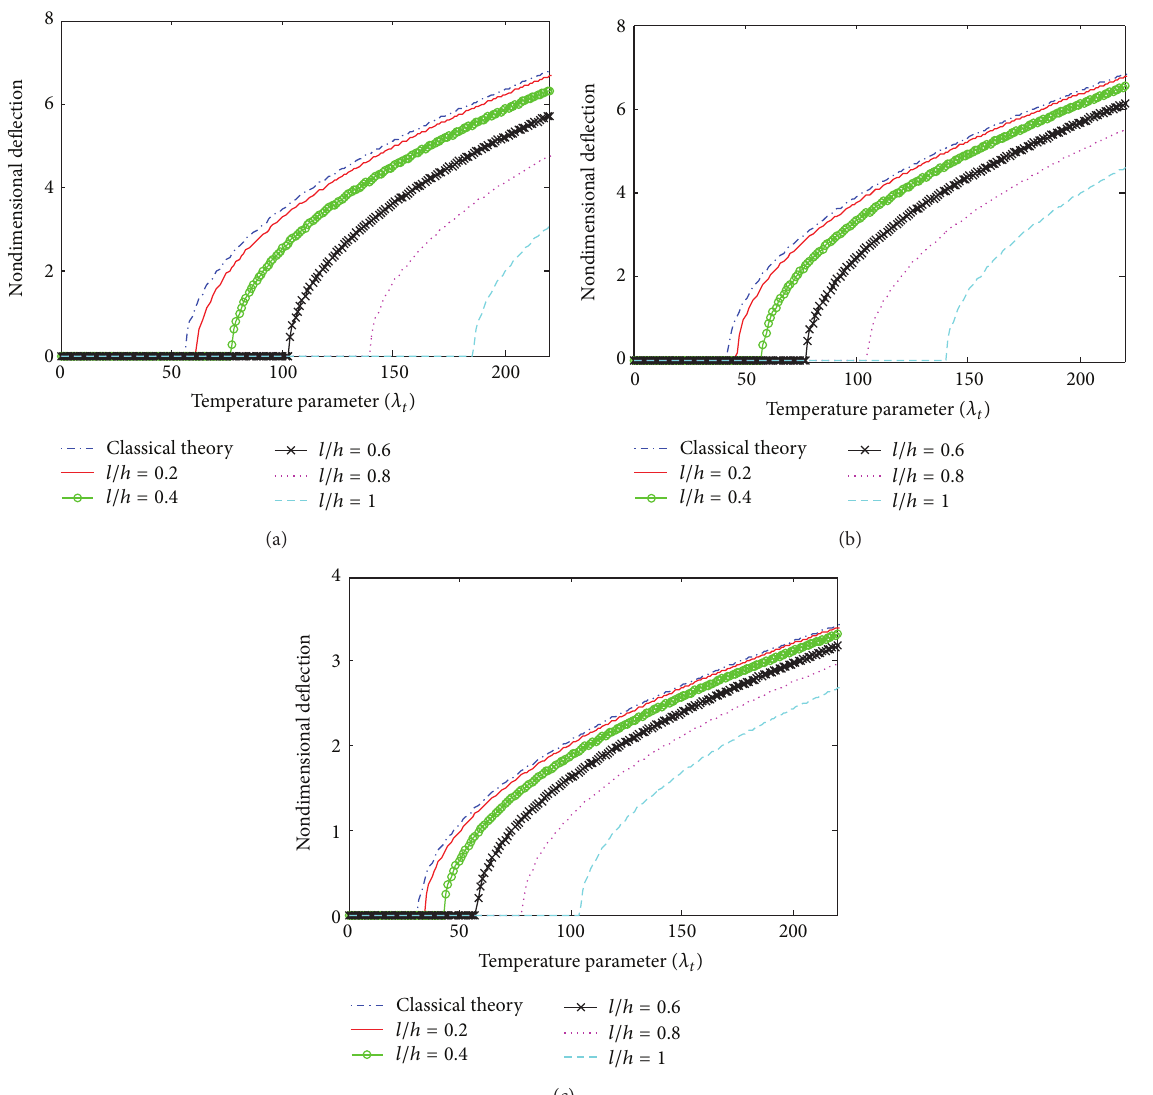
Figure 7: Variation of the nondimensional deflection ( ̂𝑥 = 0.25 ) of (a) clamped-clamped, (b) clamped-simply supported, (c) simply supported-simply supported FG beam with the temperature parameter for different values of 𝑙/ℎ ( 𝑘 = 1 , 𝐿/ℎ = 40 , third buckling